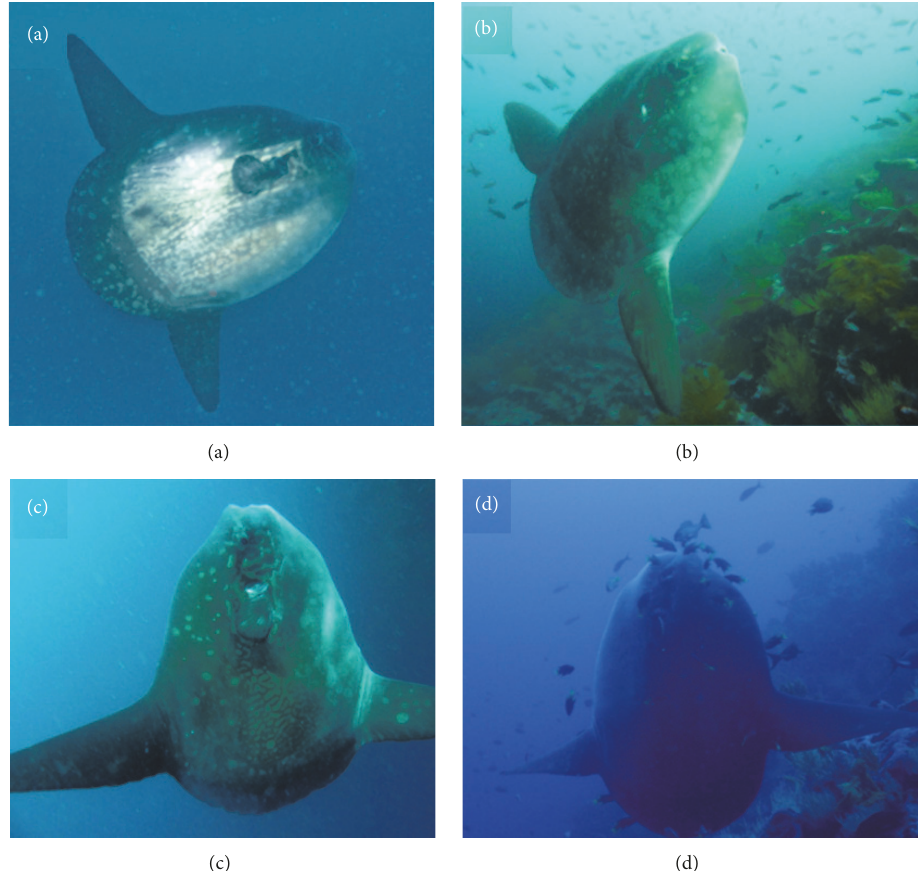
Figure 3: M. ramsayi at reef cleaning station, Punta Vicente Roca, Galapagos, Ecuador. (a) Individual approaching the reef from the pelagic environment. (b) Individual moving towards the reef and turning to a head-up position. (c) Individual in head-up position. Photos in (a), (b), and (c): K. Weng. (d) Individual being cleaned by juvenile Mexican hogfish B. diplotaenia and a single ocean whitefish, Caulolatilus affinis . Photo: frame grab from video footage taken aboard M/V Alucia’s Triton 3300 submersible piloted by Mark Taylor, 11 September 2015.